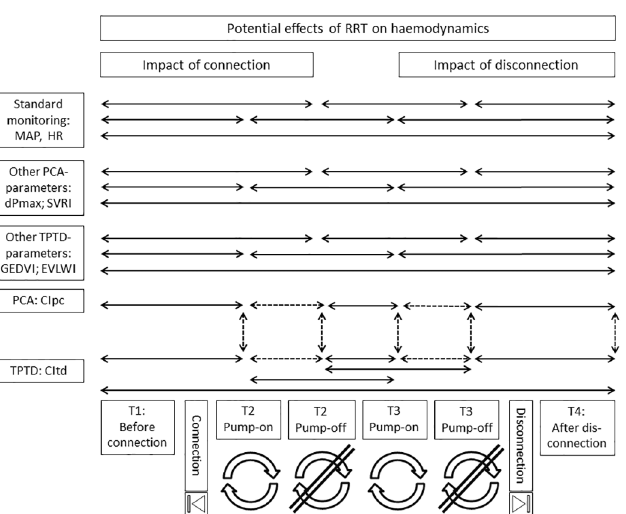
Fig 2. Flow-chart of potential comparisons before, during and after renal replacement therapy (RRT). Solid lines are used for comparisons aimed at potential real haemodynamic effects of RRT. Dashed lines are given for comparisons aimed at validation of transpulmonary thermodilution (TPTD) technique. MAP: mean arterial pressure. HR: heart rate. PCA: pulse contour analysis. GEDVI: global end-diastolic volume index. EVLWI: extra-vascular lung water index. CI: cardiac